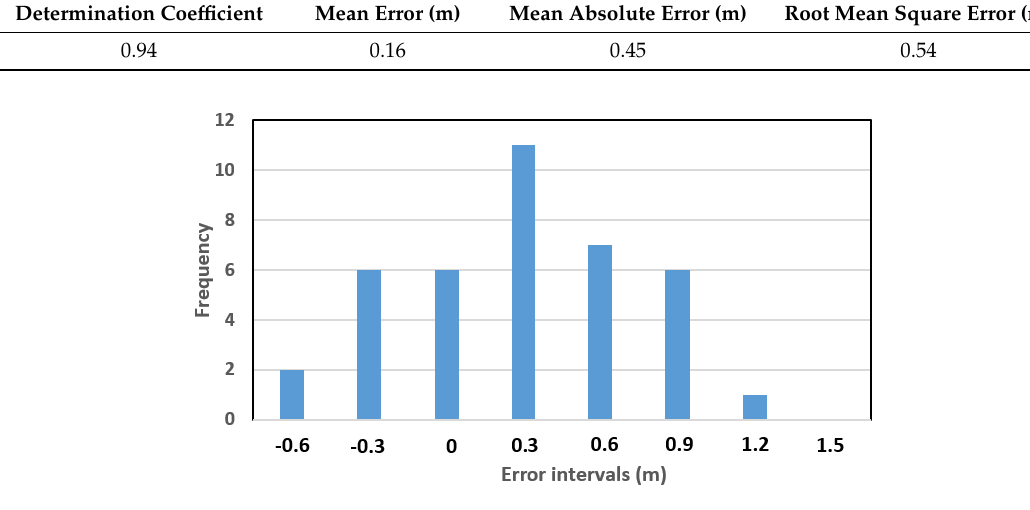
Figure A2. Distribution of the Figure A2. distribution of the errors.